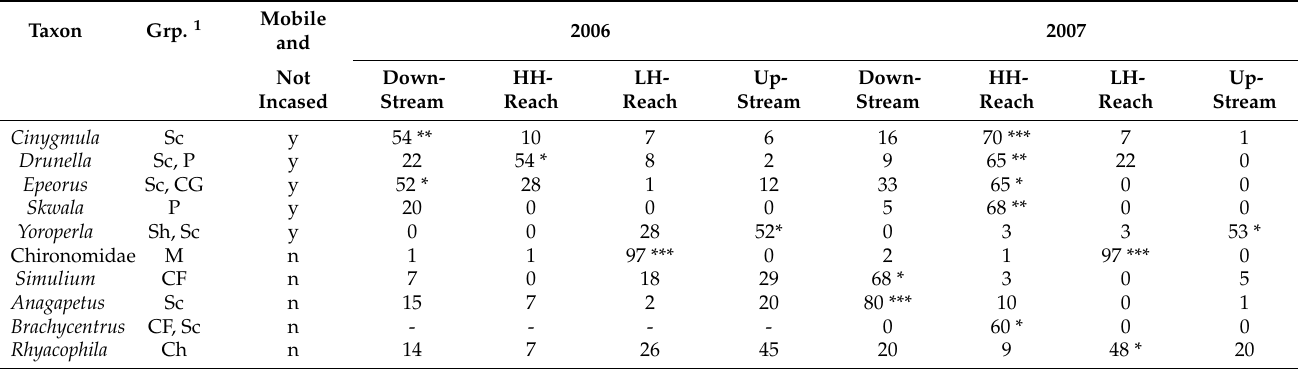
Table 3. Indicator Species values (percentage of a perfect indication) for macroinvertebrate taxa. Taxa shown have an indicator value significantly greater ( α = 0.05) than values generated by 1999 Monte Carlo simulations, in at least 1 year of sampling.